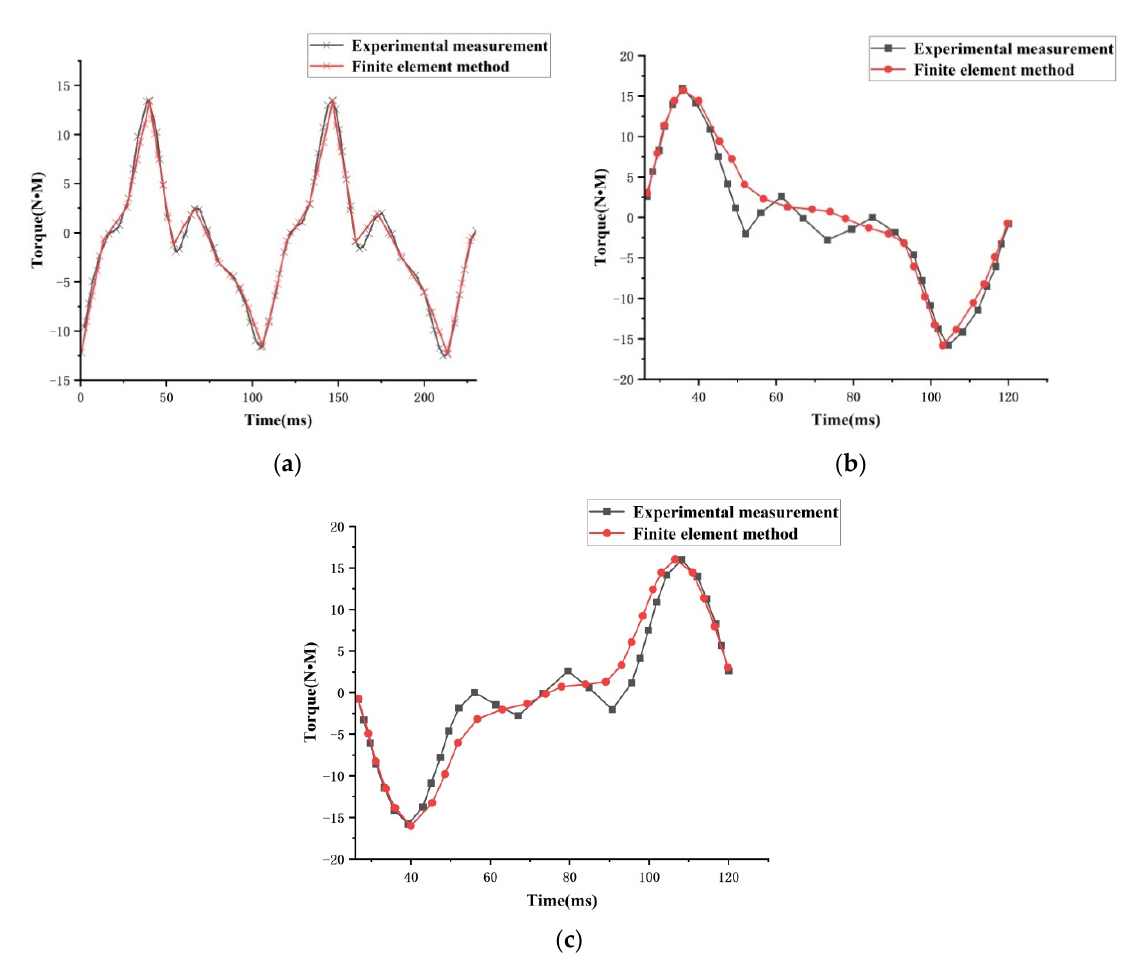
Figure 16. The 3D force sensor data measurement system.